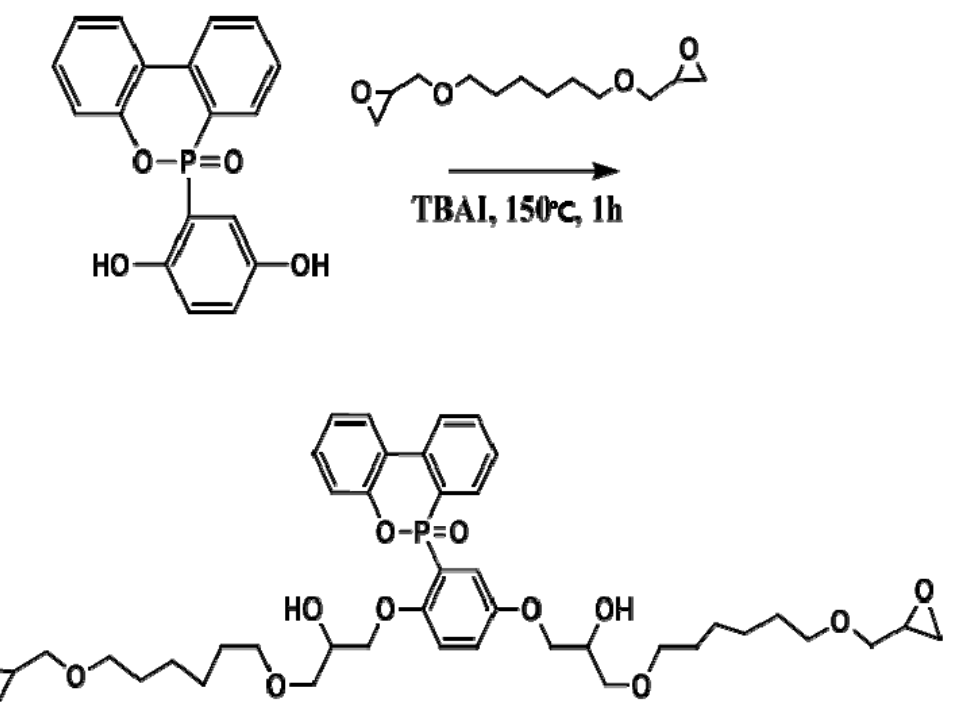
Figure 1. Preparation of polyol (EP-DOPO) reaction scheme.